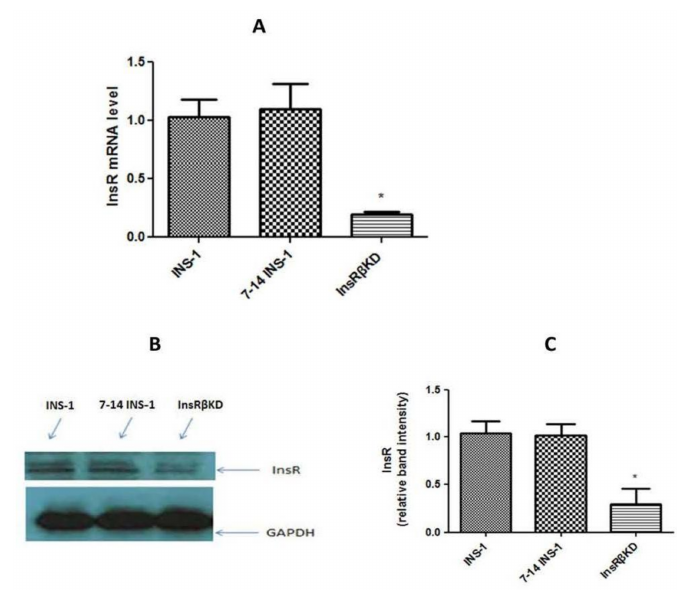
Figure 4. InsR expression in transduced cells. ( A ) qPCR result of measuring InsR mRNA levels in the 3 cell lines. The quantity level was firstly normalized to that of endogenous control glyceraldehyde 3-phosphate dehydrogenase (GAPDH) and then expressed relative to that in INS-1 cells. ( B ) A representative Western blot analysis of InsR protein levels in INS-1, 7-14 INS-1, and InsR β KD cells. GAPDH protein was similarly analysed as the loading control. ( C ) The densitometry analysis of band intensities of InsR relative to these of GAPDH. * p < 0.05, n = 3.